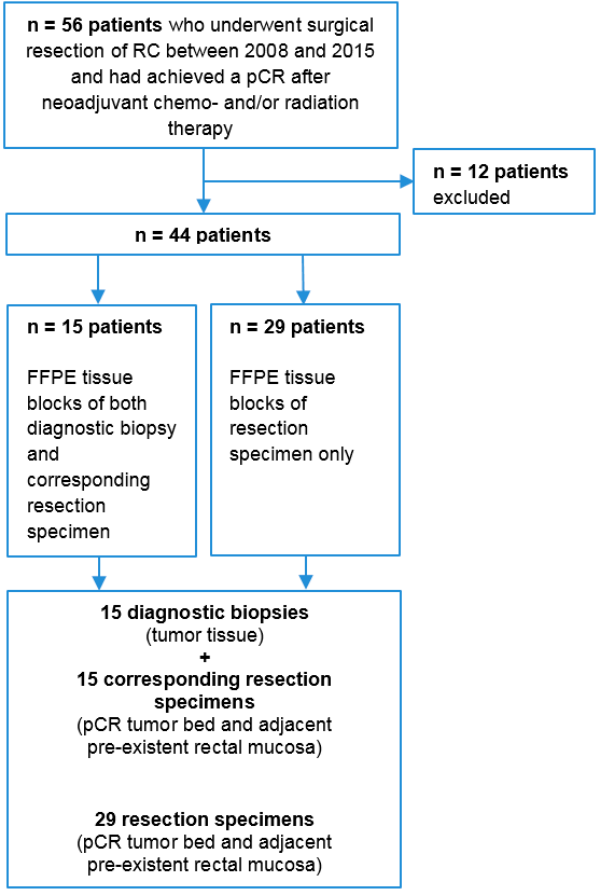
Figure 1. Overview of included tissues. Notes: Described are the number of included tissues. Fifty-six patients were selected. Twelve patients were excluded. From fifteen of the remaining 44 patients, FFPE tissue blocks of both diagnostic biopsy and resection specimen of the corresponding primary tumor were available. From 29 patients, only tissue blocks of the resection specimen were available. Abbreviations: RC, rectal cancer; pCR, pathological complete response; FFPE, formalin-fixed